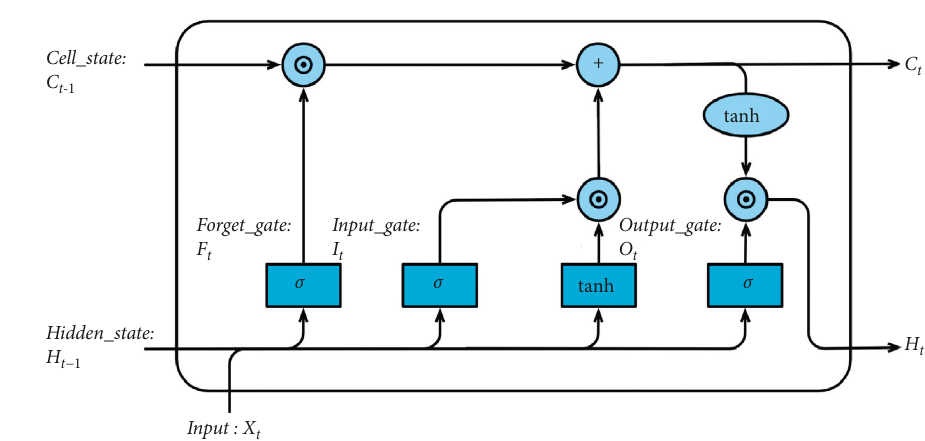
Figure 2: The details of the LSTM cell.